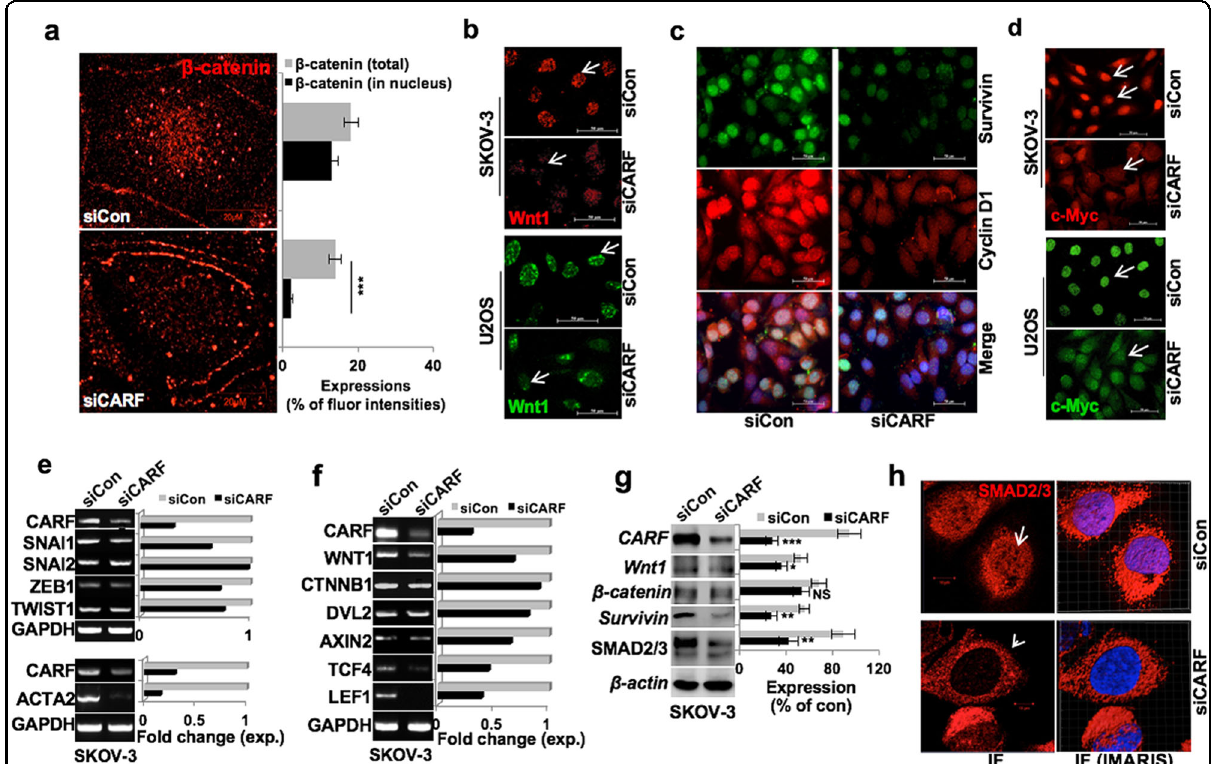
Fig. 6 CARF knockdown diminished EMT progression via abrogating β -catenin nuclear translocation. a Immunostaining showing depletion of β -catenin expression in nucleus in CARF knockdown cells; quantitation of total and its nuclear level is shown at right. b Wnt1 immunostaining showing reduced nuclear foci in both, SKOV-3 and U2OS CARF-compromised cells. c Survivin and Cyclin D1 immunostaining showing their reduced levels in SKOV-3 CARF/siRNA cells. d c-Myc immunostaining showing a decrease in its expression in CARF knockdown both, SKOV-3 and U2OS cells. e Transcript levels of the SNAIL1, SNAIL2, ZEB1, TWIST1, and ACTA2 ( α SMA), and f the β -catenin target genes; WNT1, CTNBB1, DVL2, AXIN2, TCF4, and LEF1 showed decrease in CARF knockdown cells; quantitation in fold change is shown on the right. g Immunoblots showing decrease in β -catenin and its effector proteins viz. Wnt1, survivin, and SMAD2/3 in SKOV-3 siCARF cells. h Immunostaining showing reduced SMAD2/3 nuclear localization in SKOV-3 siCARF cells; interactive IMARIS image with semi-transparent nuclear (blue) are shown on the